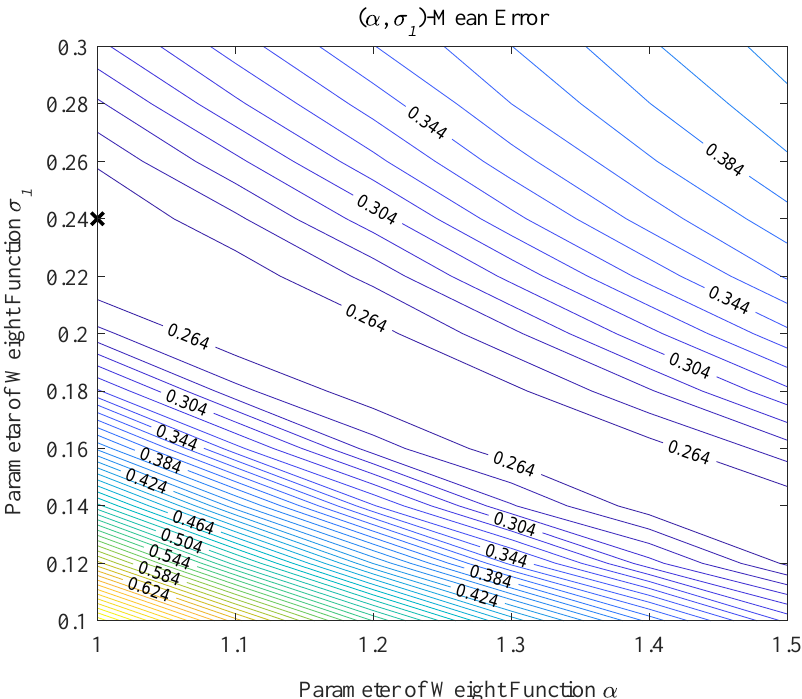
Figure 17. The relationship between the average localization errors and the two parameters α and σ l . The x axis is parameter α and the y axis is parameter σ l . The contour lines are the average localization error. The black cross is the local minimum